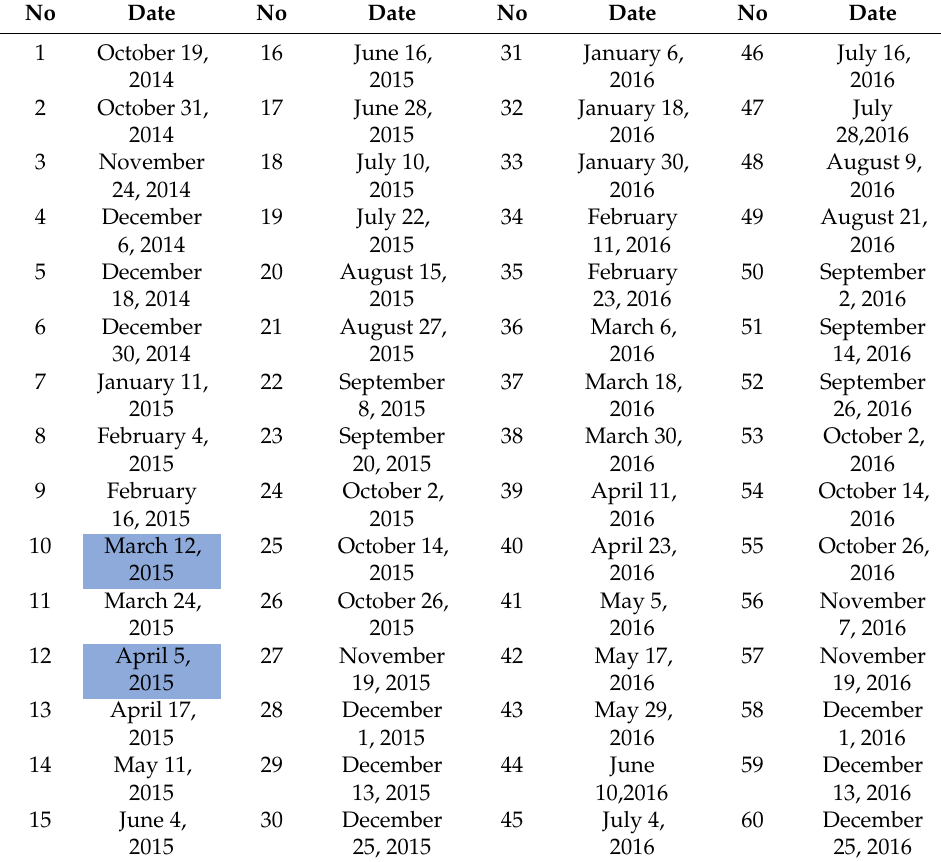
Table 1. Acquisition dates of the Sentinel (S-1) satellite data used for Greece / Turkey. The scenes acquired on March 12, 2015 and April 5, 2015 (highlighted with blue background) were used as flood event images for two di ff erent parts (northern and southern) of the Greece / Turkey study area.